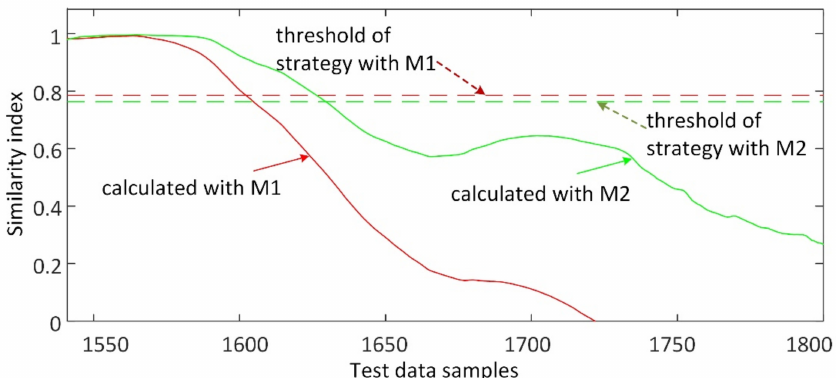
Figure 10. Similarity index values of the test